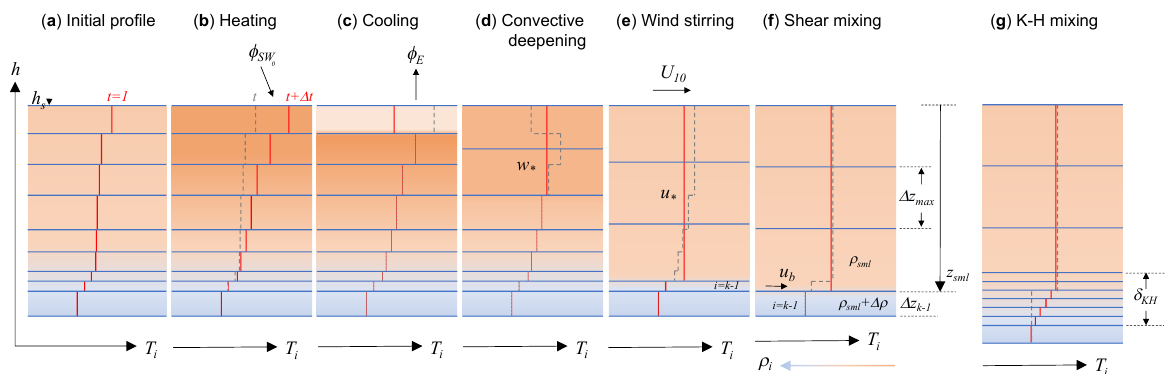
Figure 8. Schematic depiction of layer changes during stratification and mixing. Consecutive panels show changes from (a) the initial layer and thermal profile, to (b) heating due to solar radiation, to (c) evaporative cooling, which creates (d) convective mixing followed by (e) a wind event causing stirring and (f) shear mixing across the thermocline. If the metalimnion remains unstable to shear it may be subjected to mixing from K–H billowing, which opens up the thermocline as depicted in panel (g) .